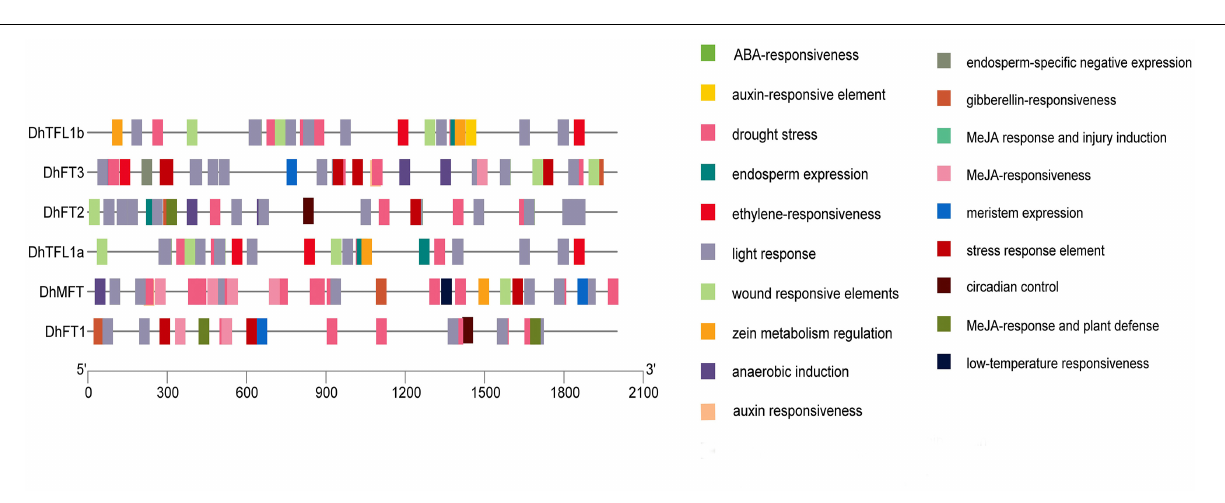
FIGURE 6 | The amino acid comparison and conserved domains of PEBP proteins. The brown arrow indicates a key amino acid residue that determines FT-like and TFL1-like functions. Black boxes denote the conserved DPDxP, GIHR motif, and L/IYN motif. Underlines represent segments A–D.